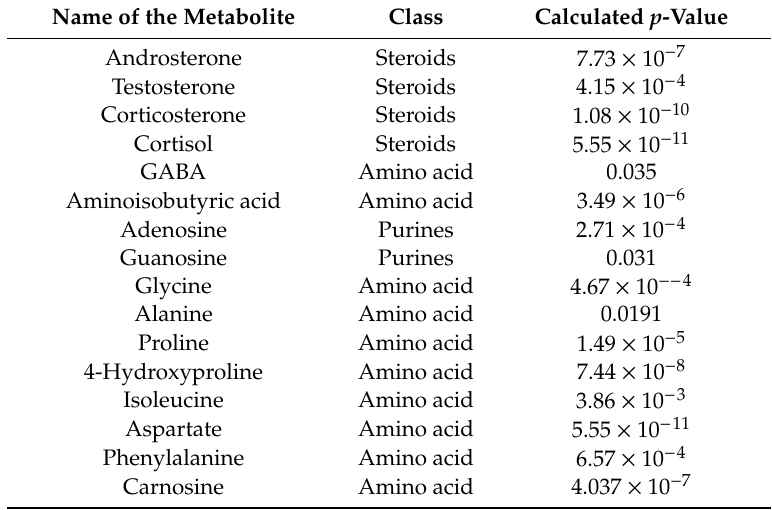
Table 2. List of the metabolites that were significantly altered after intravenous administration of Prostanit in rabbits. p -Values were calculated by comparison of the areas under the curve (AUC) of the analyzed metabolites in tested and vehicle control groups using parametric or non-parametric a / b tests (Student t -test and Mann–Whitney test, respectively).